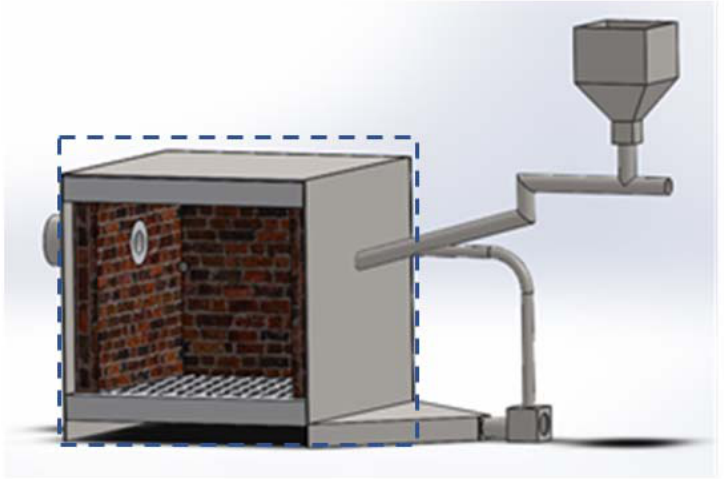
Figure 4. Thermodynamic system and domain simulated in ANSYS FLUENT.